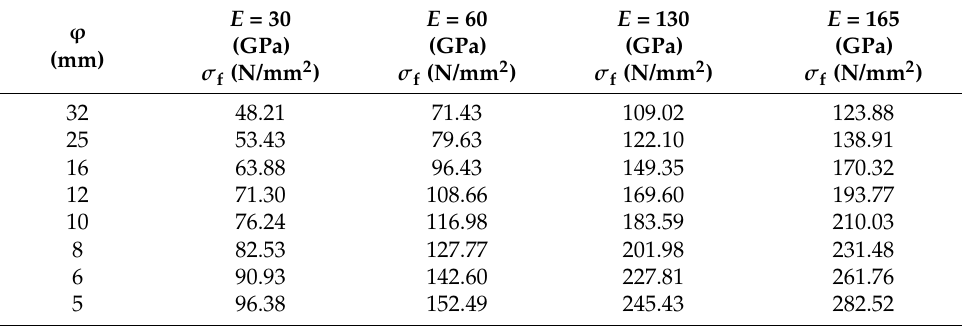
Table 3. Stresses in FRP bars for maximum allowable bar diameter and k 1 =